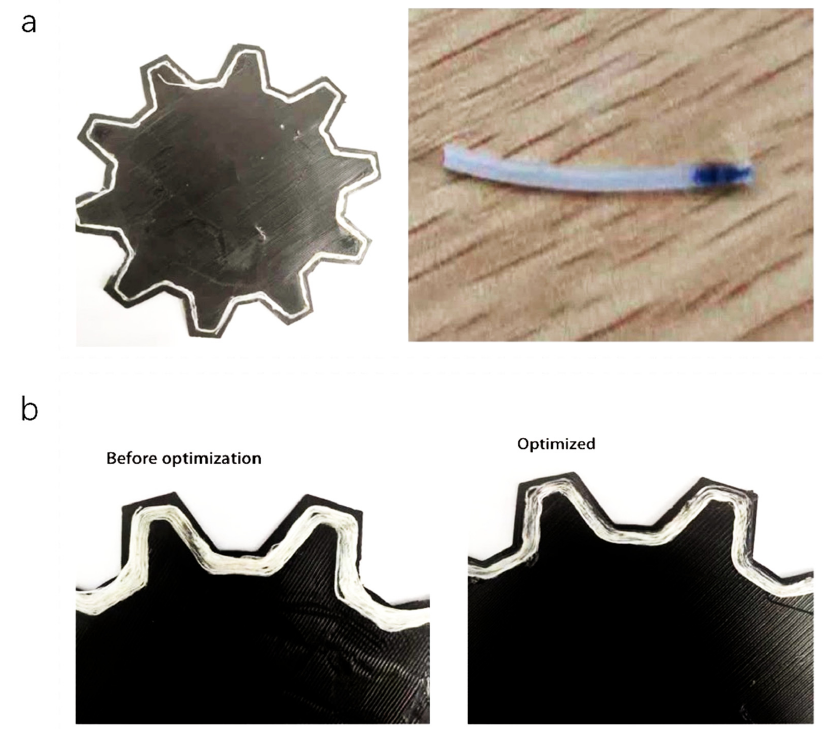
Figure 11. ( a ) Printing failure. ( b ) Corner optimization algorithm before and after the printing effect. Table 4. Printing failure statistics for CFRF.